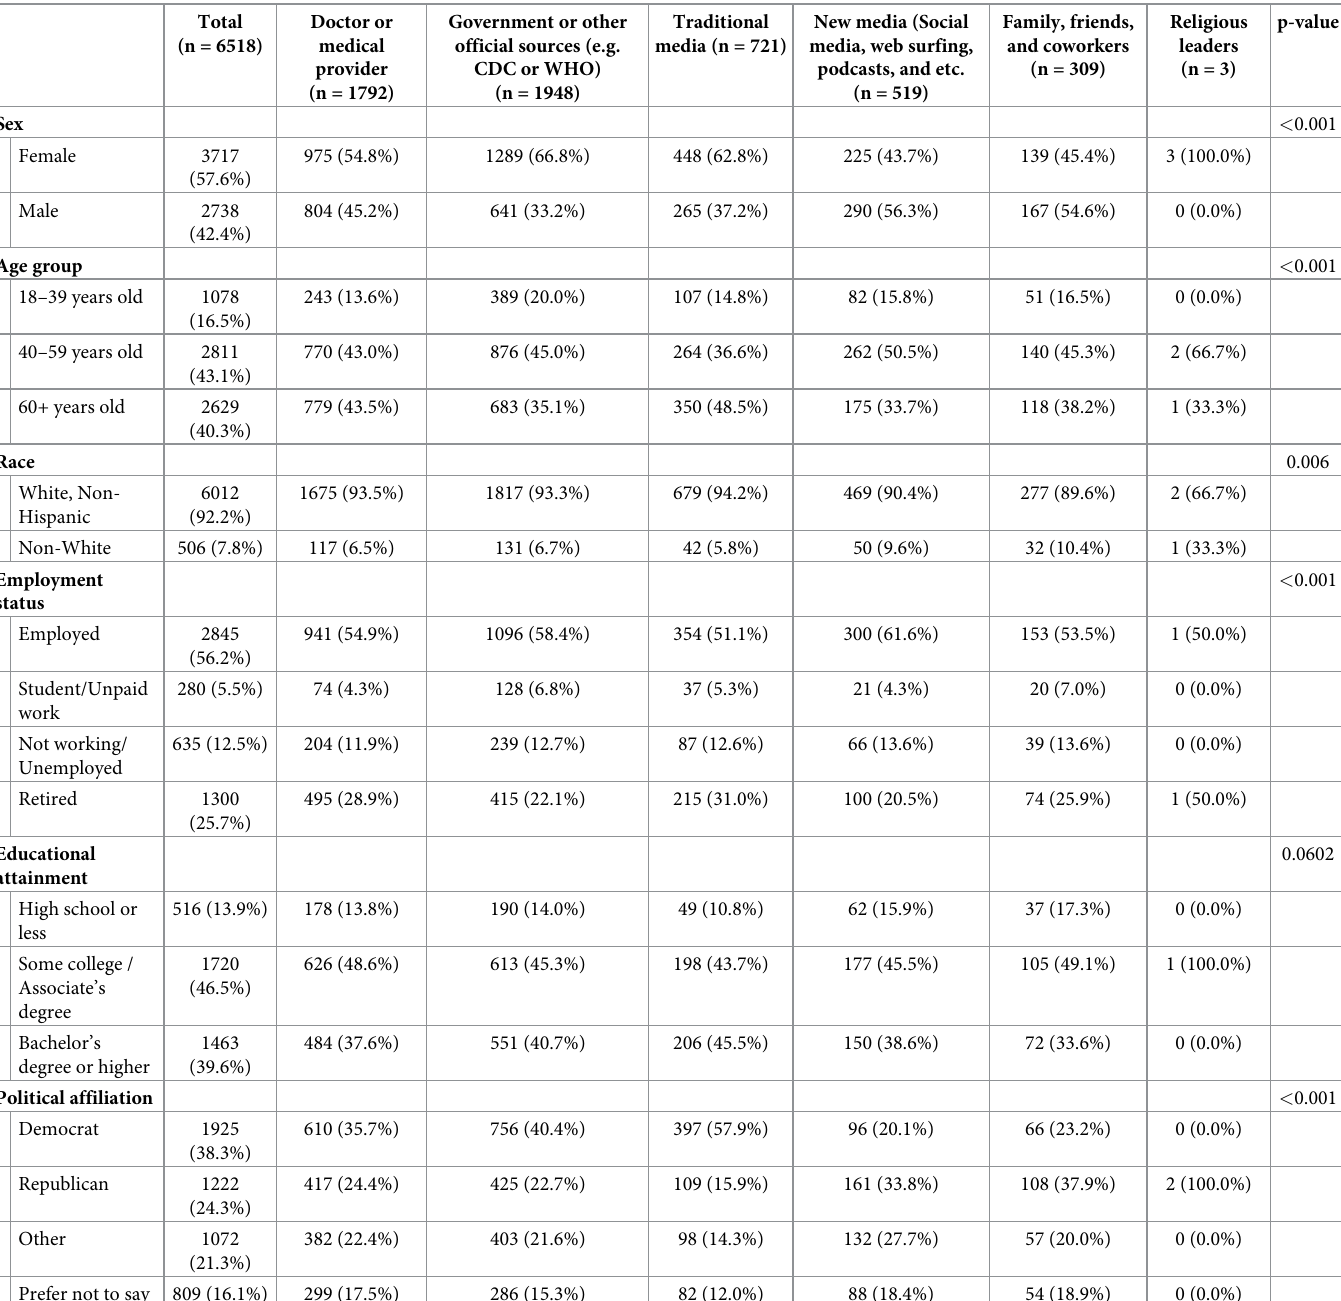
Table 1. Demographics of the study participants (n =